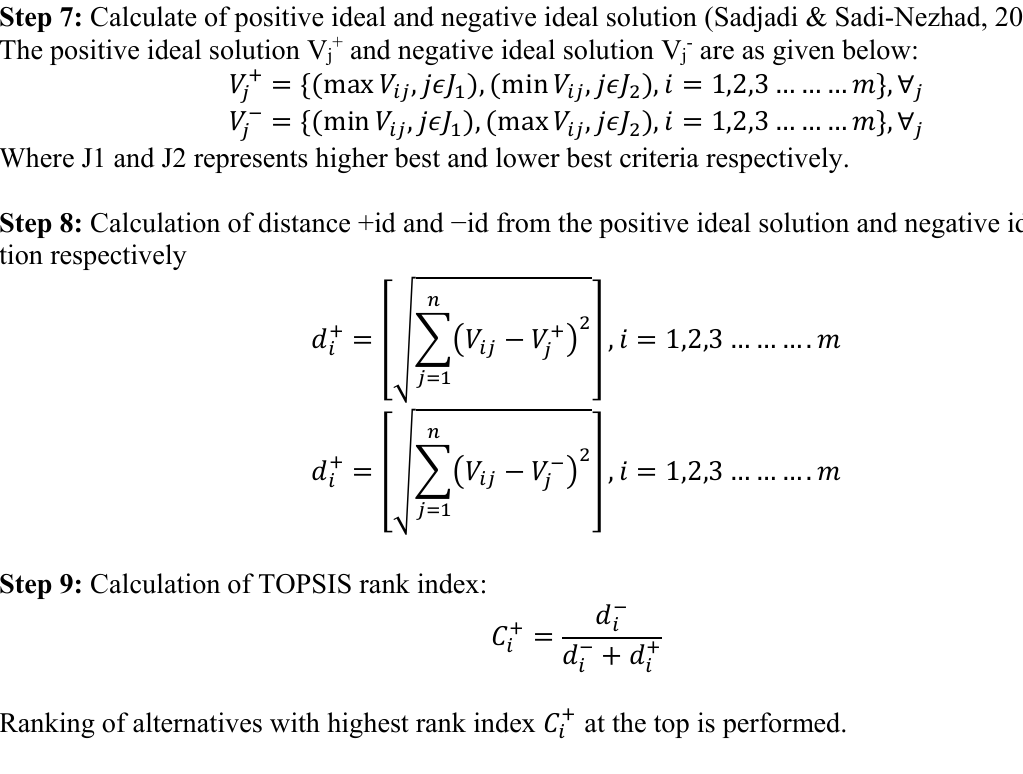
Various Parameters with their Brief Description Sr. No. Parameters Abbreviation Detail 1 Equipment Variation EV Variation due to equipment in use Appraiser Variation AV Variation due to persons handling the process Gauge R & R GRR Variation due to inability of measurement system Part Variation PV Variation in different parts produced by process Total Variation TV Sum of all three types of variations